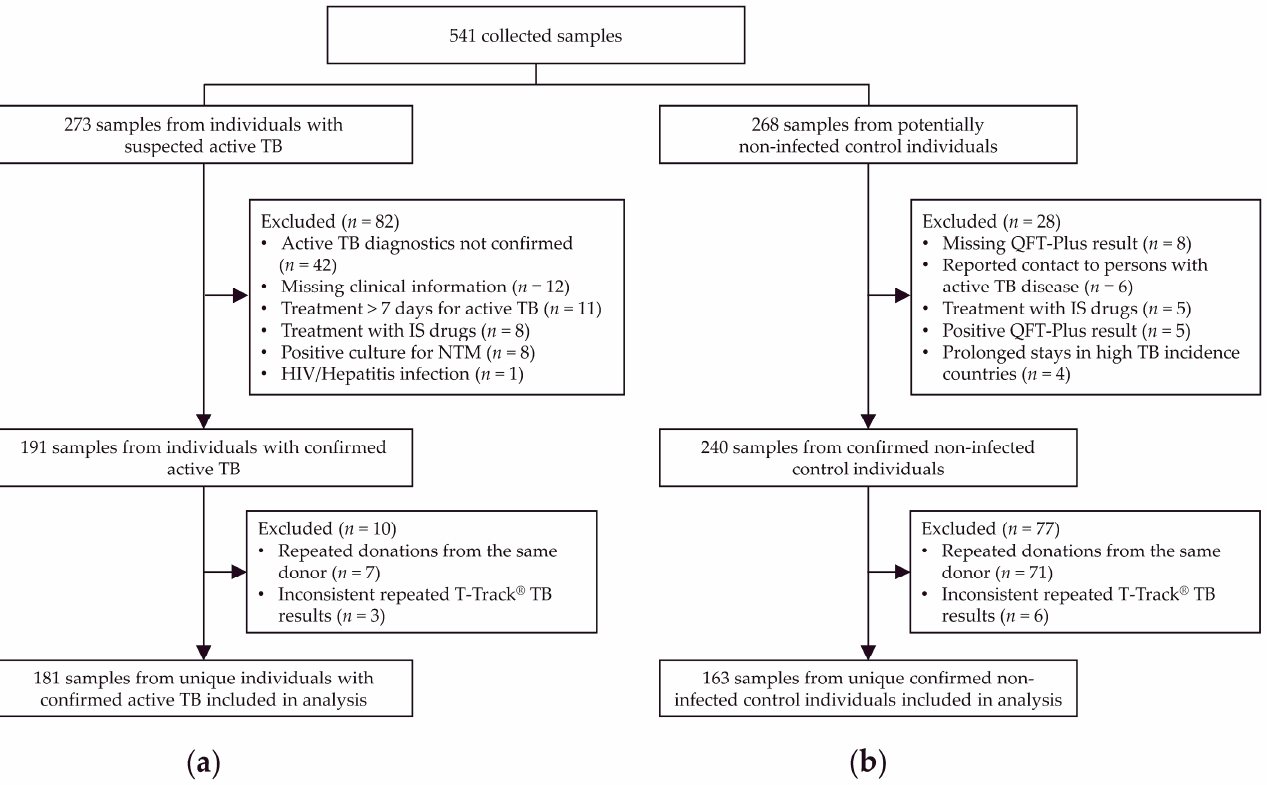
Figure 2. Study flow diagram. Out of 541 collected samples, 273 were from patients with suspected active TB ( a ) and 268 from presumed non ‐ infected individuals ( b ). After exclusion of samples not meeting inclusion/exclusion criteria, and exclusion of samples from multiple collections from the same donor and with inconsistent T ‐ Track ® TB results upon repeated testing, a total of 344 samples were analyzed, including 181 from patients with confirmed active TB ( a ) and 163 from confirmed non ‐ infected controls ( b ). Abbreviations: HIV, human immunodeficiency virus; IGRA, interferon ‐ gamma release assay; IS, immunosuppressive; MTC Mycobacterium tuberculosis complex; NTM, nontuberculous mycobacteria; QFT ‐ Plus, QuantiFERON ® ‐ TB Gold Plus; TB, tuberculosis. The characteristics of the study participants included in the analysis are shown in Table 1. Demographics of study participants according to TB infection Table 1. The median (range) age of TB patients and controls was 35 (18–91) and 28 (18–78) years, respectively. The group of TB patients was ethnically more diverse (52.5% European, 22.6% African, 22.1% Asian) than the control group (99.4% European) and included more men (69.1% vs. 36.2% in TB patients vs. controls) (Table 1). Of 181 analyzed TB patients, 177 (97.8%) were defined as active TB by a positive Mtb culture and four (2.2%) by a positive microscopy and PCR (Table S2). In addition, 153/181 (84.5%) TB patients were diagnosed with pulmonary TB, either as single ‐ organ involvement (122/181 [67.4%]) or with extra ‐ pulmonary organ involvement (31/181 [17.1%]), while 28/181 (15.5%) were diagnosed with extra ‐ pulmonary TB only (Table S2).